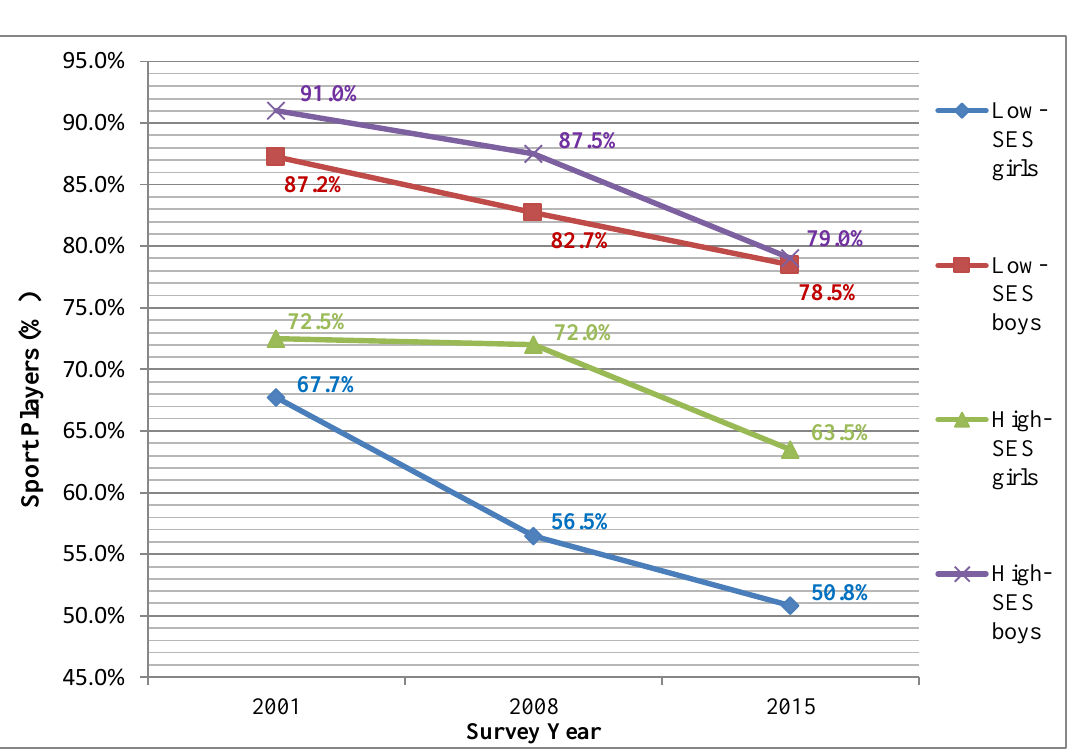
Figure 1. Sport participation rates by sex and socioeconomic status (SES) by year.